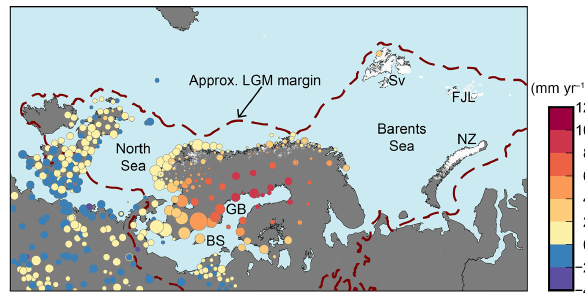
Figure 1. Rates of vertical land motion (mmyr − 1 ) for the GPS data used in the inversion, after correction for elastic effects (Sect. 2.3). BS – Baltic Sea; FJL – Franz Josef Land; GB – Gulf of Bothnia; NZ – Novaya Zemlya; Sv – Svalbard; FJL and NZ – Russian Arc- tic. Dark red dashed line (Hughes et al., 2016) shows the approx- imate boundary of ice cover at the Last Glacial Maximum (LGM) (ice cover on Iceland not shown). White shading indicates present- day glaciers. The size of the circles is inversely proportional to the measurement